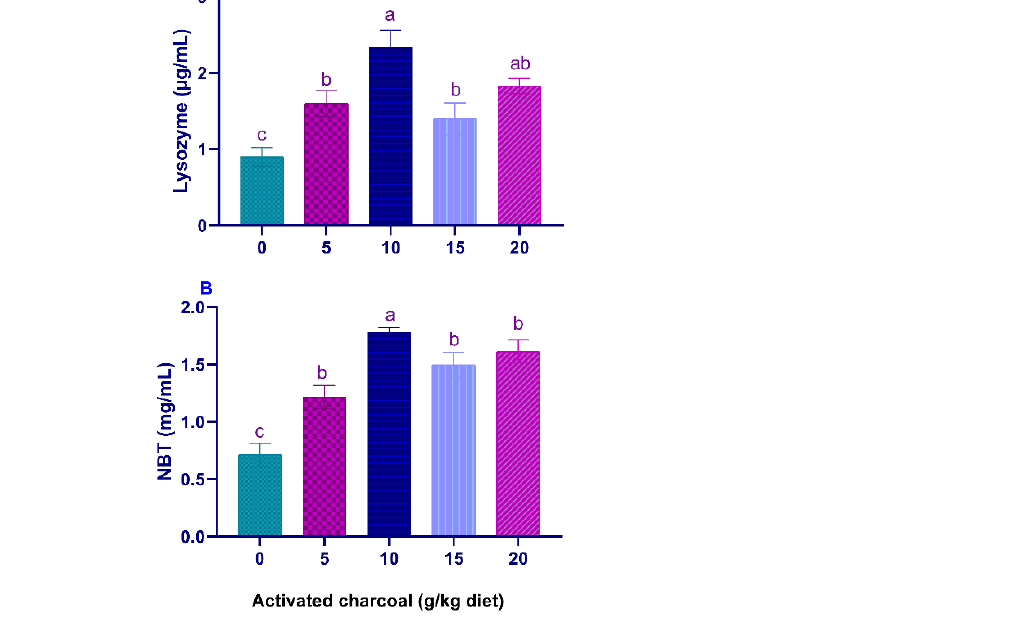
Figure 1. Serum lysozyme (LYZ) activity ( A ) and Nitro blue tetrazolium (NBT) levels ( B ) of Nile tilapia fed diets supplemented with graded, activated charcoal (AC) levels for 8 weeks. (a, b, c) indicate significant differences between groups.